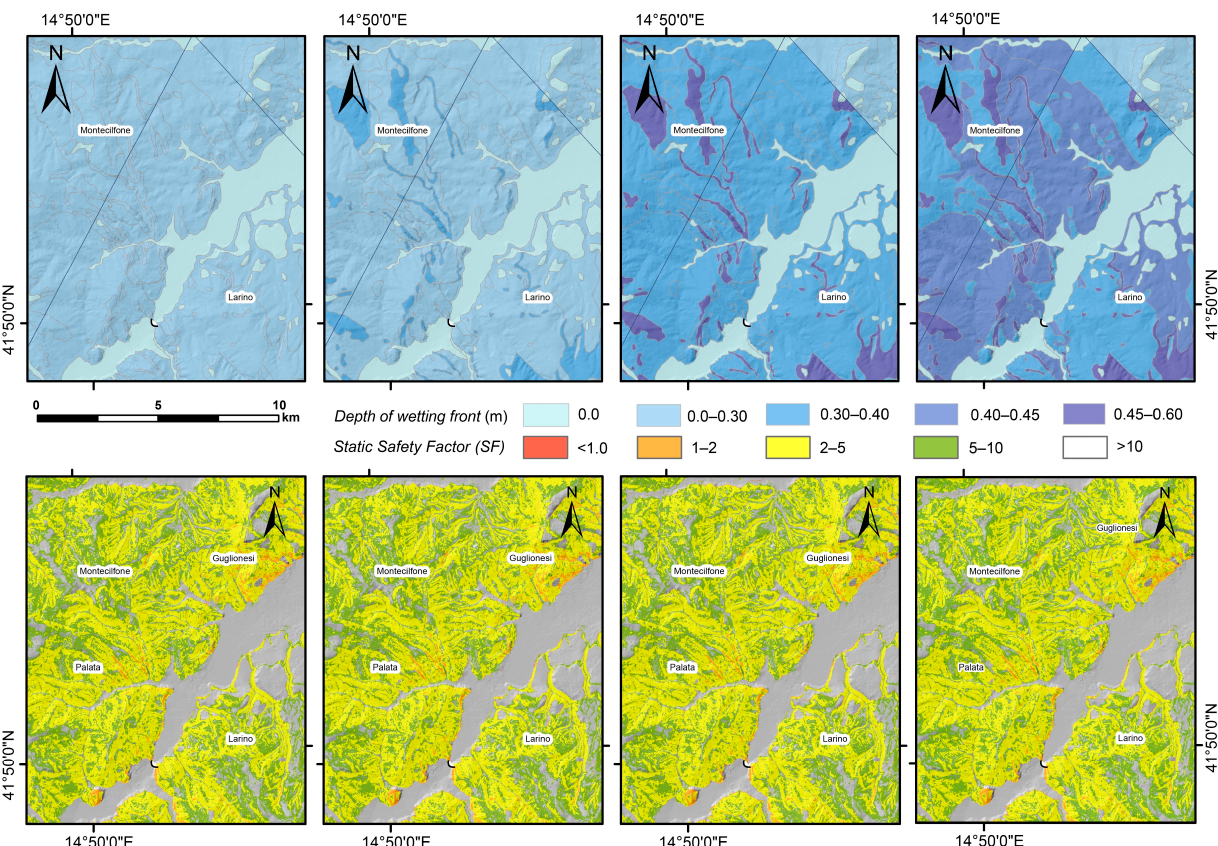
Figure 8. Maps showing the depth of the infiltration water table ( upper row ) and the values of the static SF ( lower row ) at a maximum depth of soil cover ( cover bottom ) at time stages from T1 to